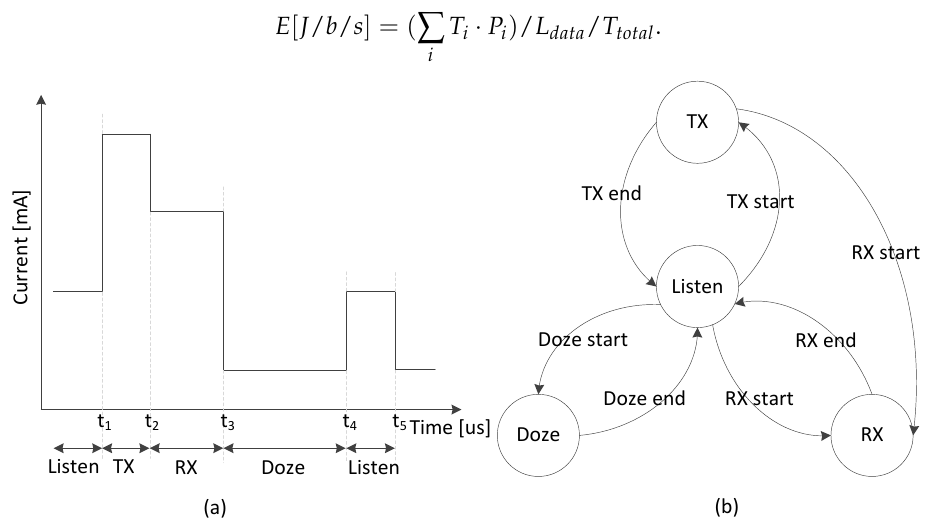
Figure 5. Energy consumption model: ( a ) current consumption for power states; and ( b ) power state flow control; TX: transmission; RX: reception. Table 1. Current consumption for different power states and bandwidth